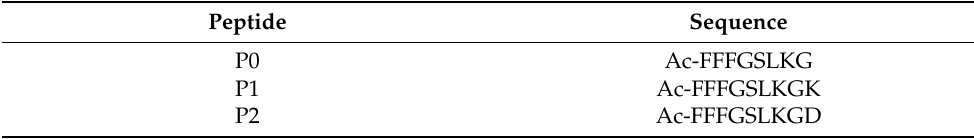
Table 1. Sequence of designed